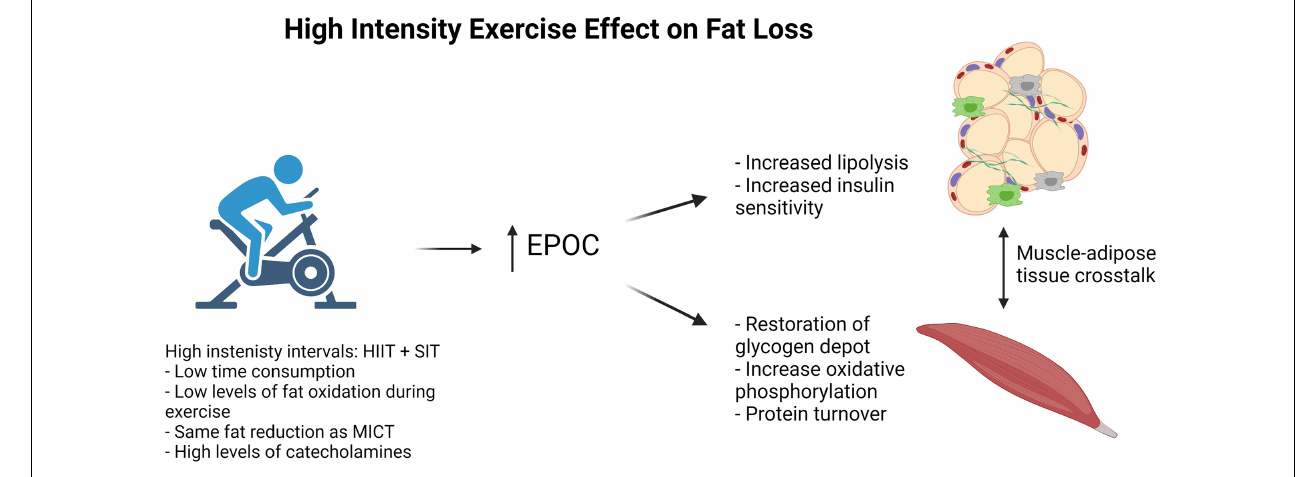
FIGURE 1 | High intensity exercise effect on fat